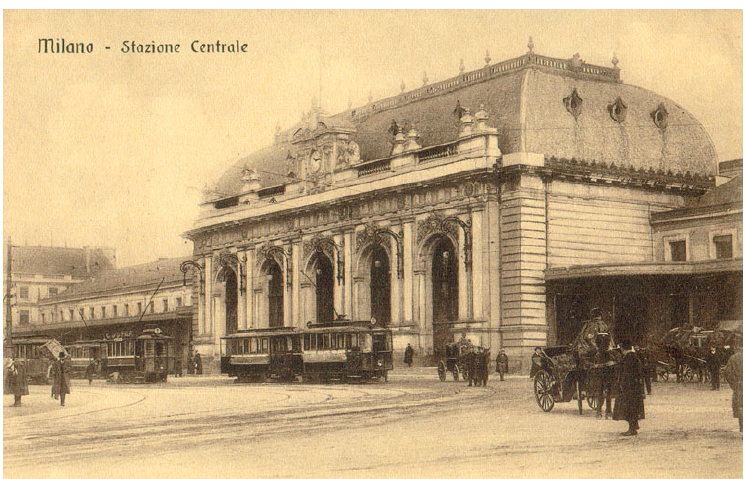
Figure 14. Old postcard of demolished central station of Milan.